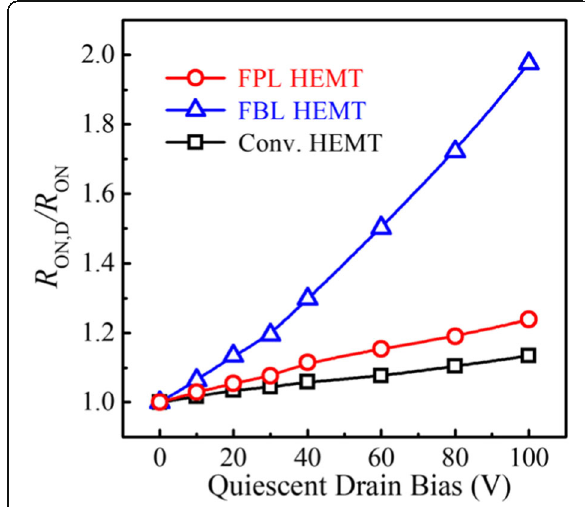
Fig. 6 Ratio of R ON, D / R ON for the fabricated HEMTs at different quiescent drain bias points. The pulse width and period are 3ms and 5ms,